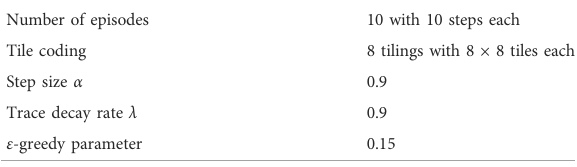
TABLE2Learningsimulationparametersandresults.Trueandlearned double-gyre model parameters over 10 learning episodes.